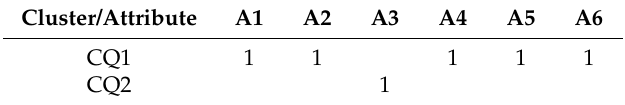
Table 11. Attribute allocation over query clusters.